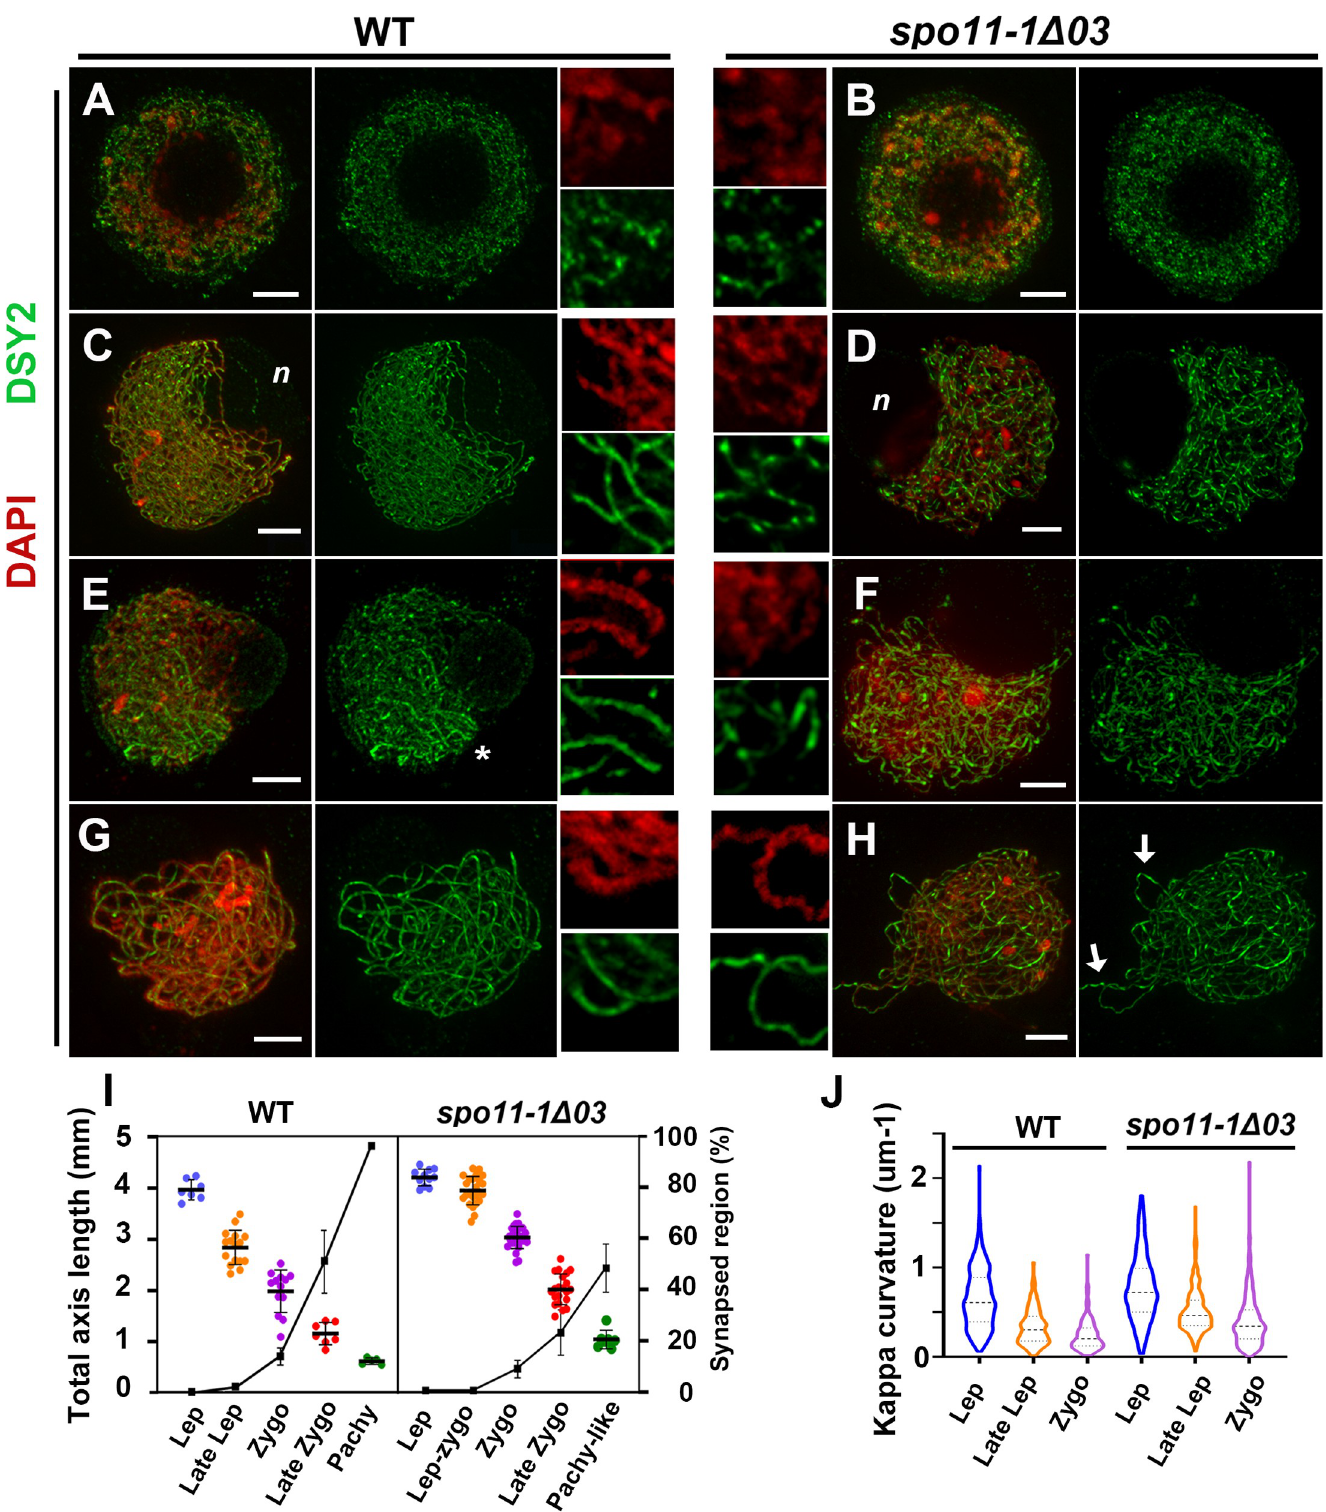
Fig 7. An aberrant axial element structure in spo11-1 mutants. Immunostaining of DSY2 (green) and DAPI staining (red) in WT (A, C, E, G) and spo11-1- Δ 03 meiocytes (B, D, F, H). Maximal projection images are displayed for entire nuclei. Magnified images of 5 μ m 2 regions are shown in the middle panel. Scale bar represents 5 μ m. (A, B) The morphology of chromosome axes is similar in WT and mutant meiocytes when DSY2 first appears in the nucleus at the early leptotene